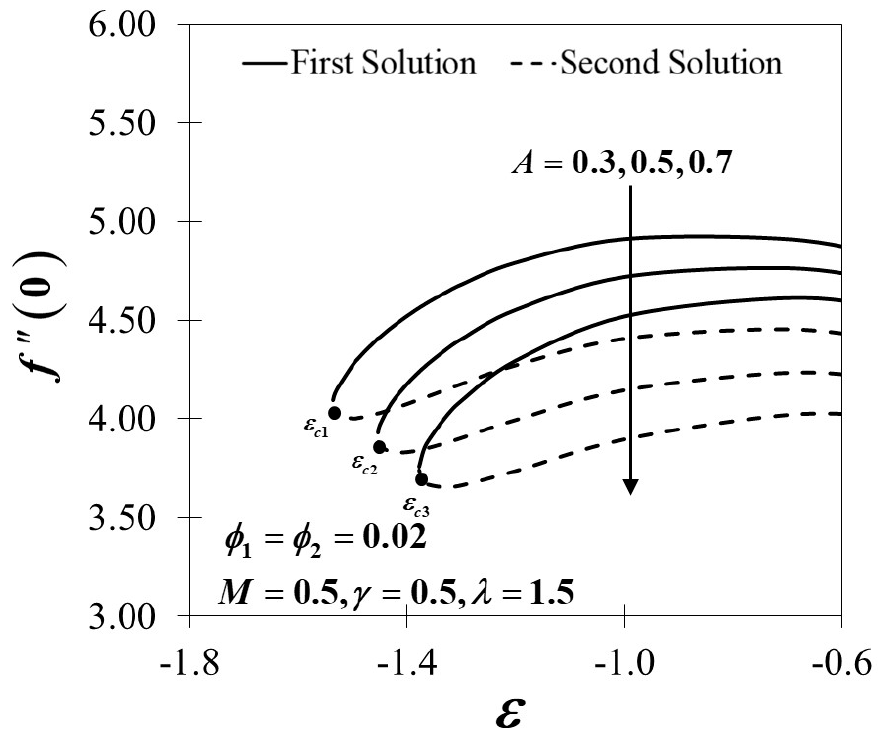
Figure 16. Variations of f ′′ (0) for different values of A .